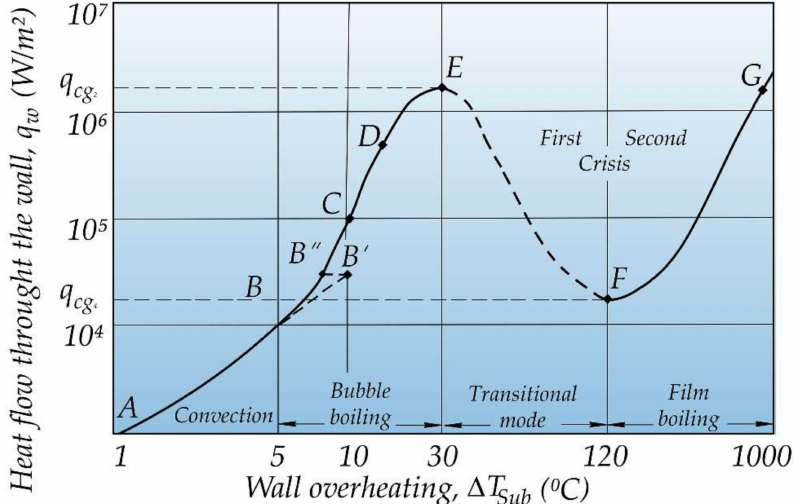
Figure 2. Regularities of modification in the heat flow penetrating the wall of cylinder head cooling jacket from the wall of its